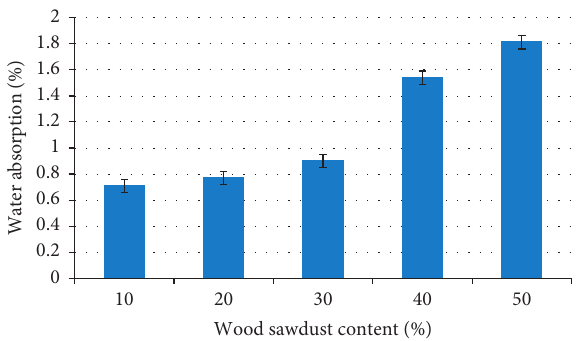
Figure 7: Effect of sawdust content on water